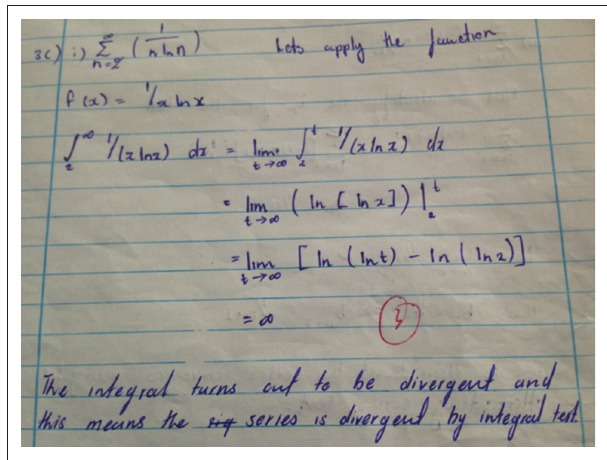
FIG URE 9: Written response of ST17 to task 1c (ii).